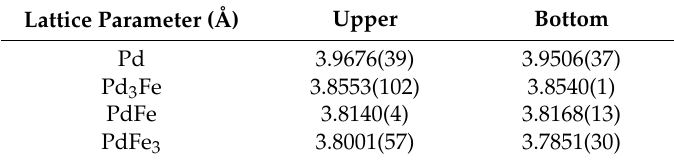
Table 1. Calculated lattice parameters of FCC phase of Pd-Fe alloy nanoparticles.